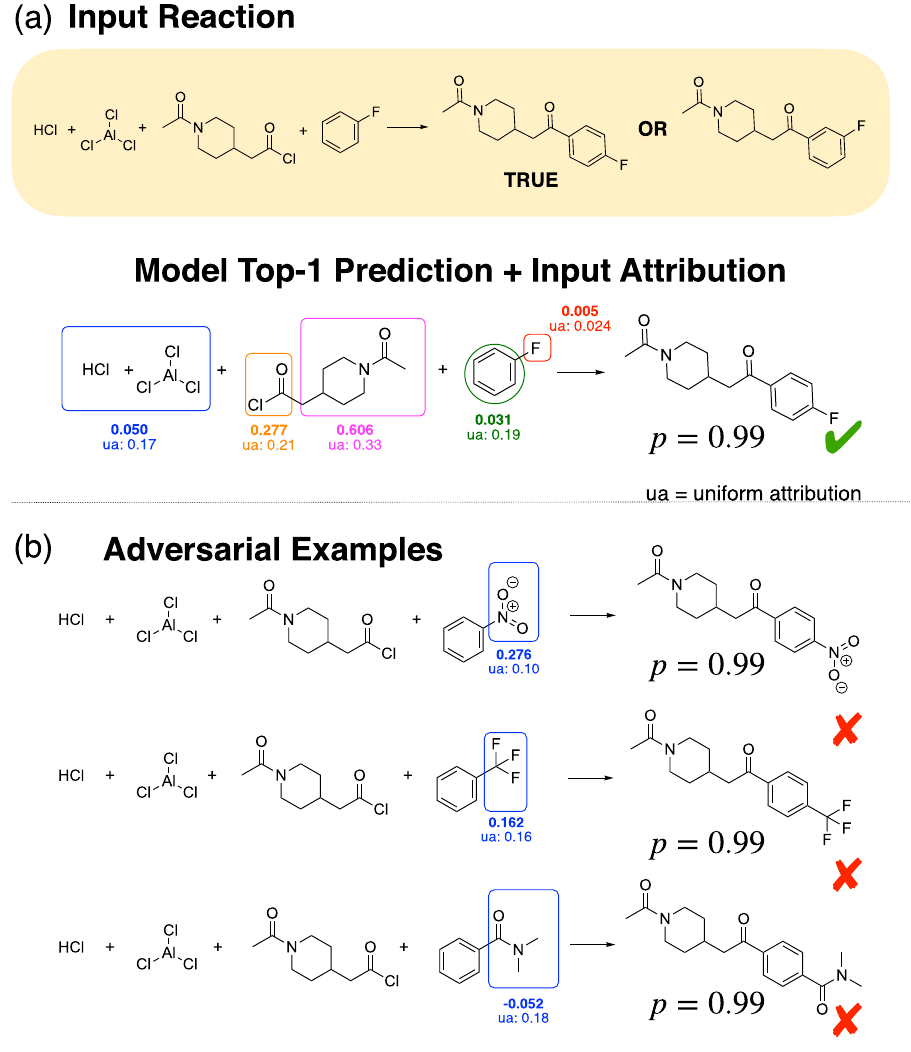
Fig. 4 IG attributions revealing incorrect reasoning and guiding the design of adversarial examples. a The model correctly predicts the major para product of a typical Friedel – Crafts acylation, but low attribution is given to the para directing – F group. b The model is fooled into incorrectly predicting the para product when the – F is replaced by meta-directing groups. The low attributions given to the directing groups indicate that the model has not learnt their